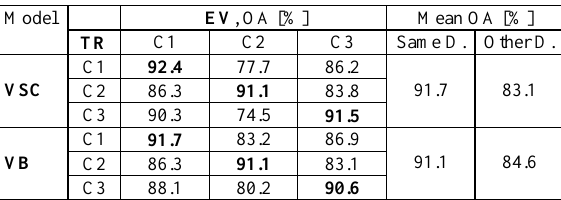
Table 4. OA of applying a classifier to other domains